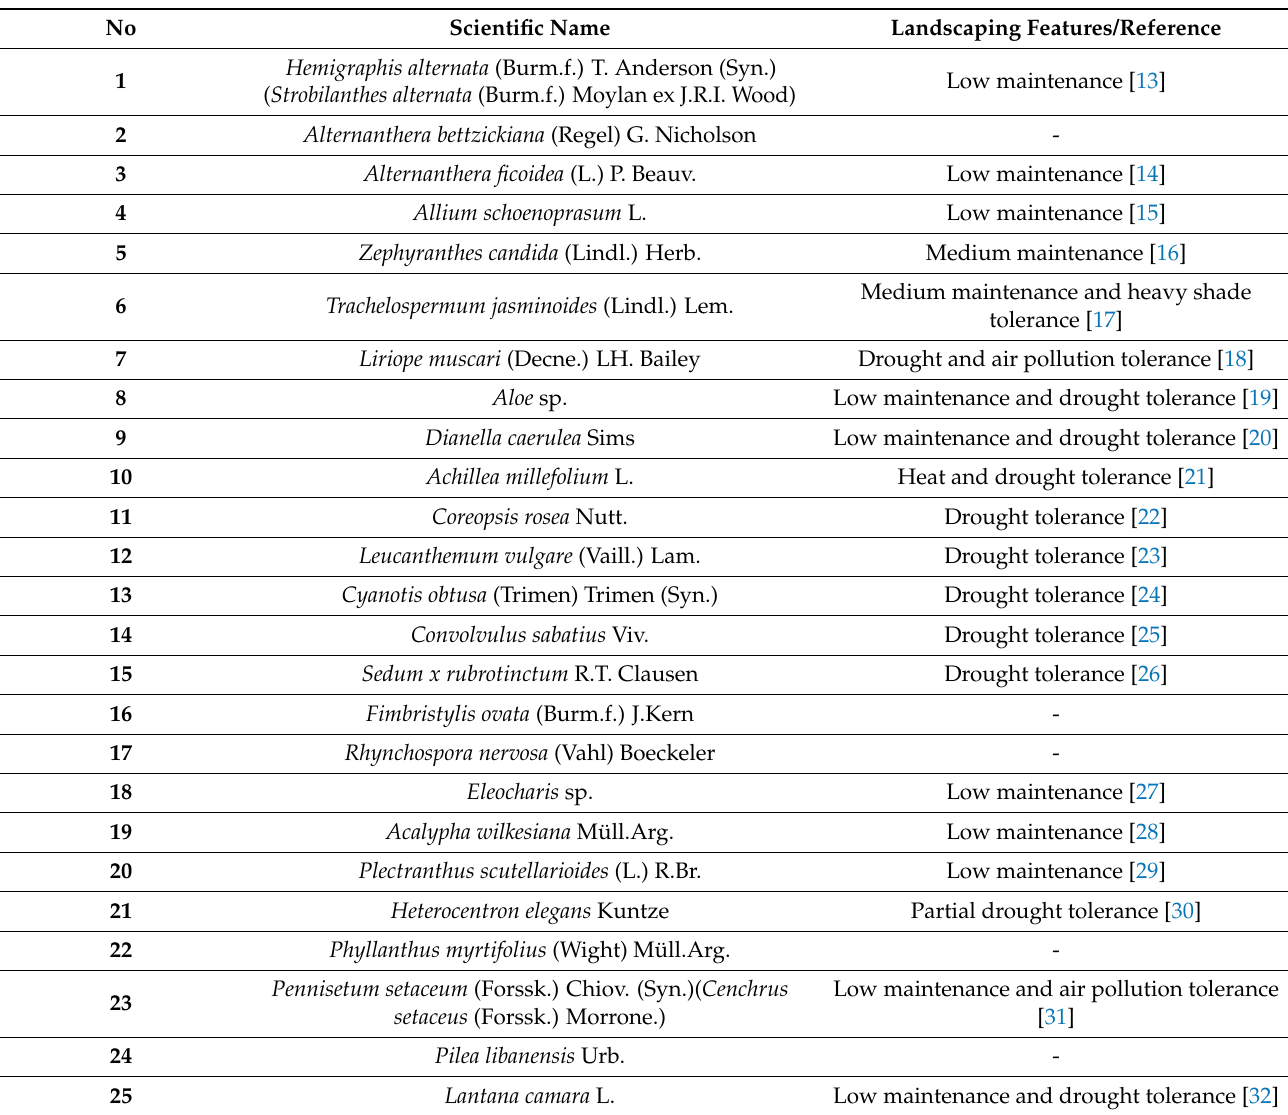
Table 1. List of the 25 studied plant species with recent information on tolerance